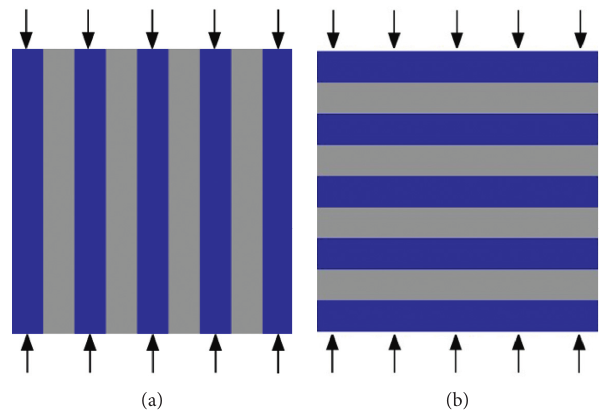
Figure 1: (a) Voigt’s equal strain model. (b) Reuss’s equal strain